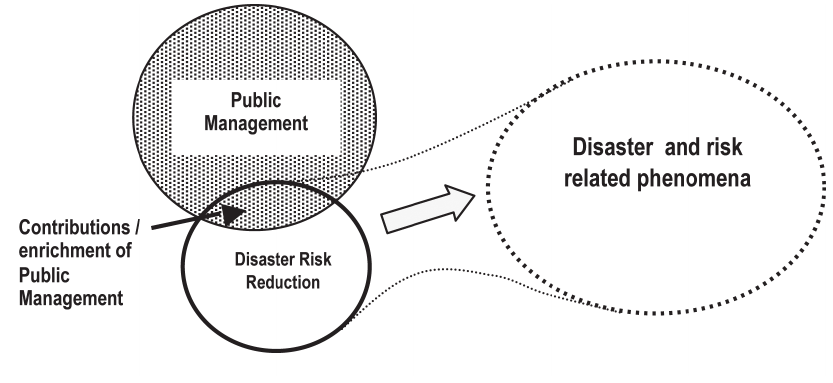
Figure 3:Interdisciplinary contributions of Public